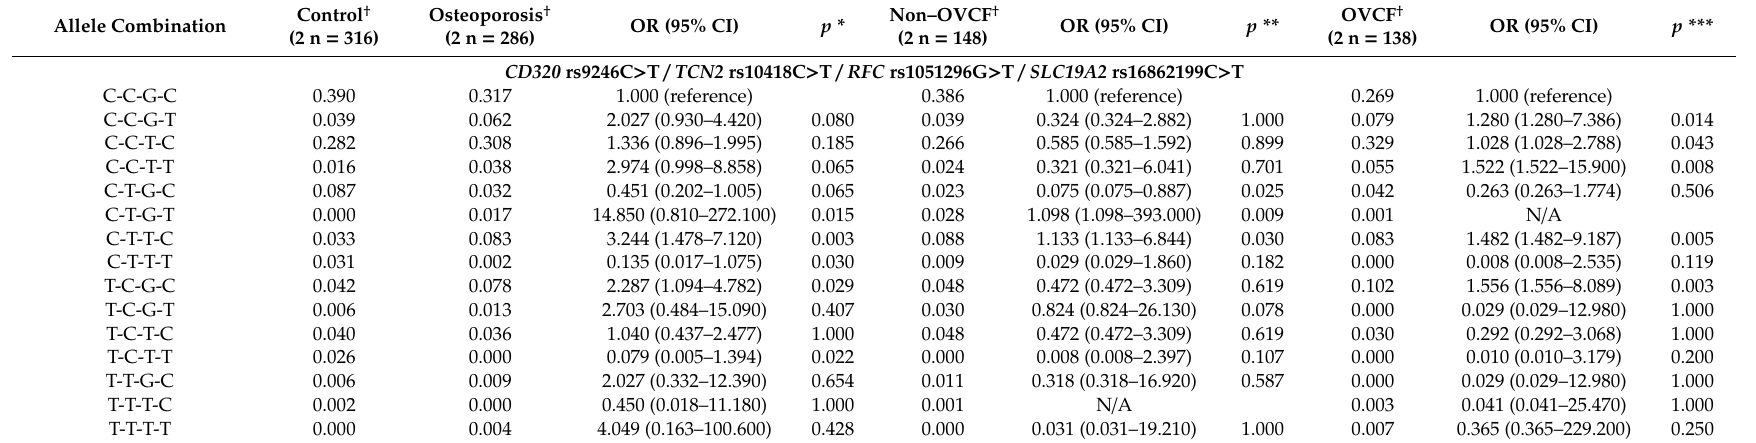
Table 3. Allele combination analysis for four vitamin B-related genes ( CD320, TCN2, SLC19A1 , and SLC19A2 ) using the multifactor dimensionality reduction method to compare genotype frequencies between OVCF and control